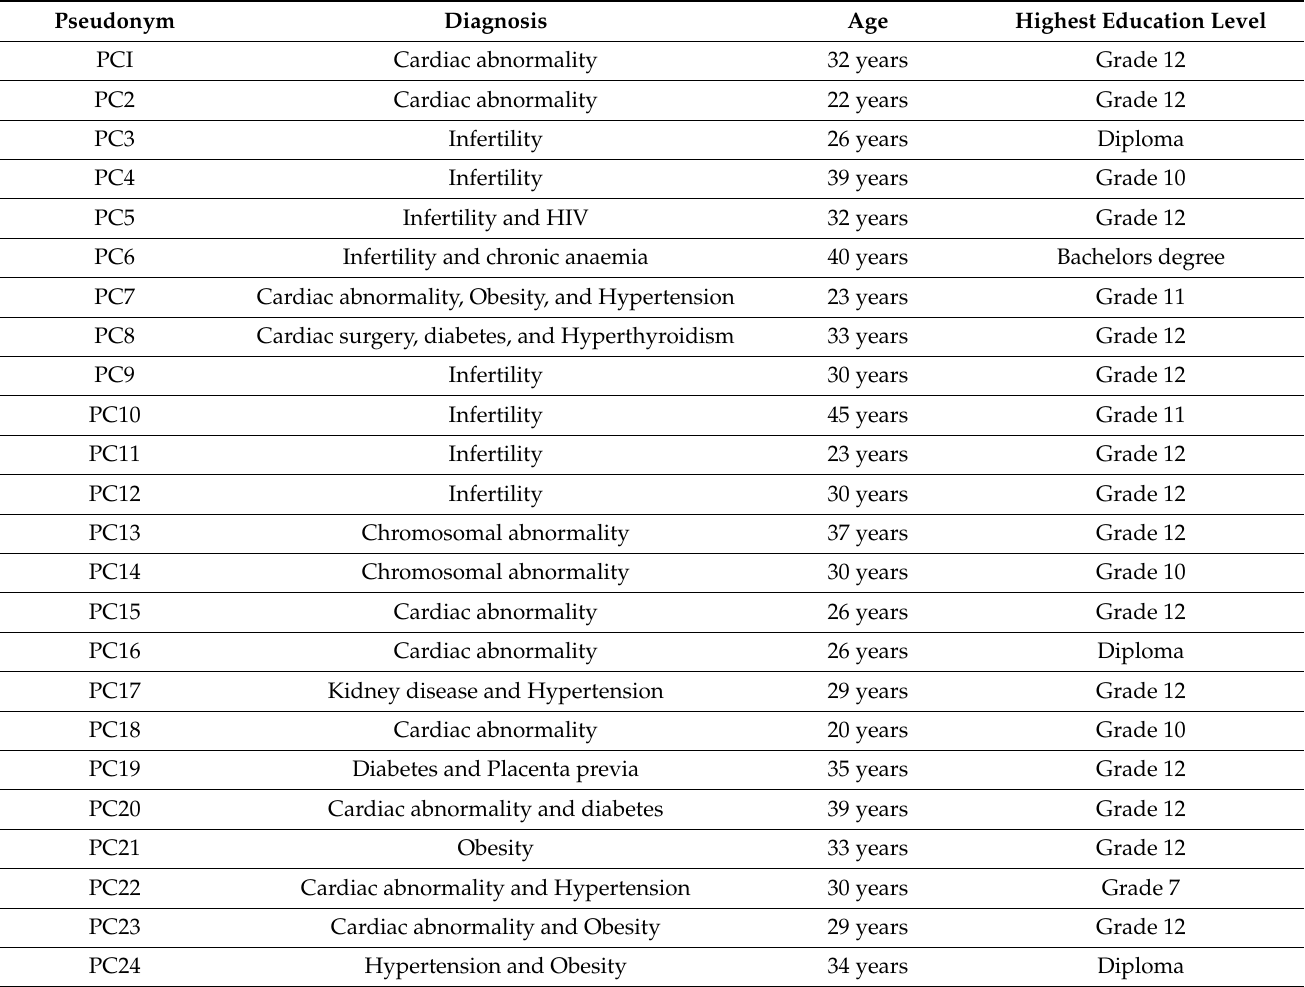
Table 1. Demographic profile of patients ( n =